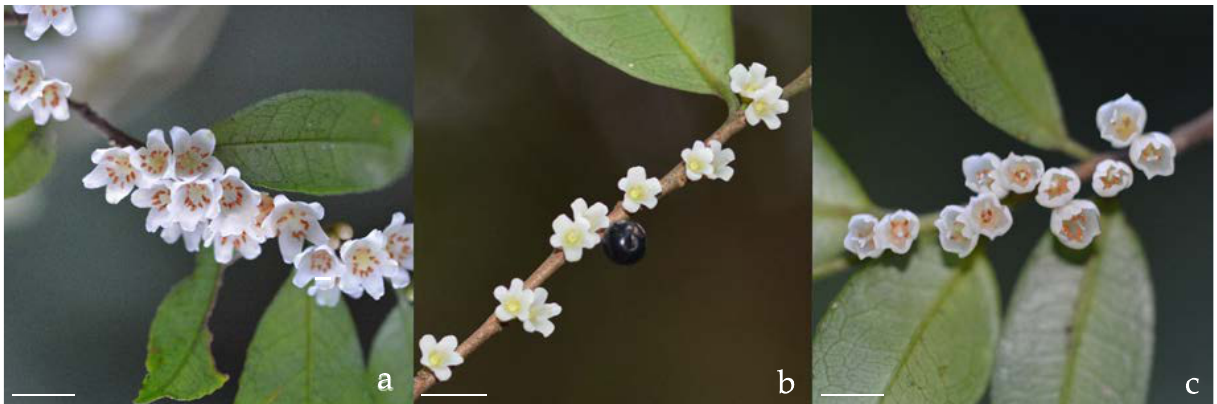
Figure 1. Flowering branches of Eurya loquaiana from male ( a ), female ( b ), and hermaphrodite ( c ) plants. The scale bars are 5 mm.